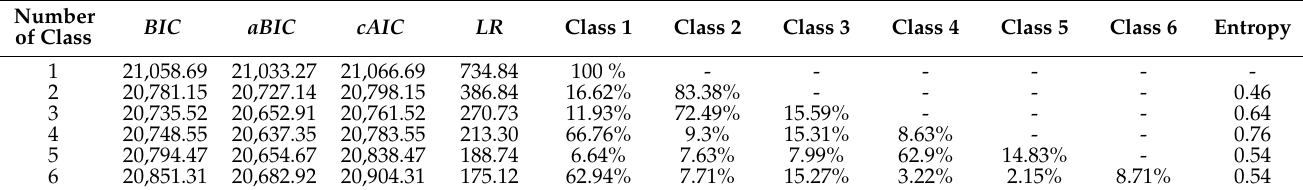
Table 4. Identification of number of profiles obtained among adolescents aged 11–18 in Benin, 2016.